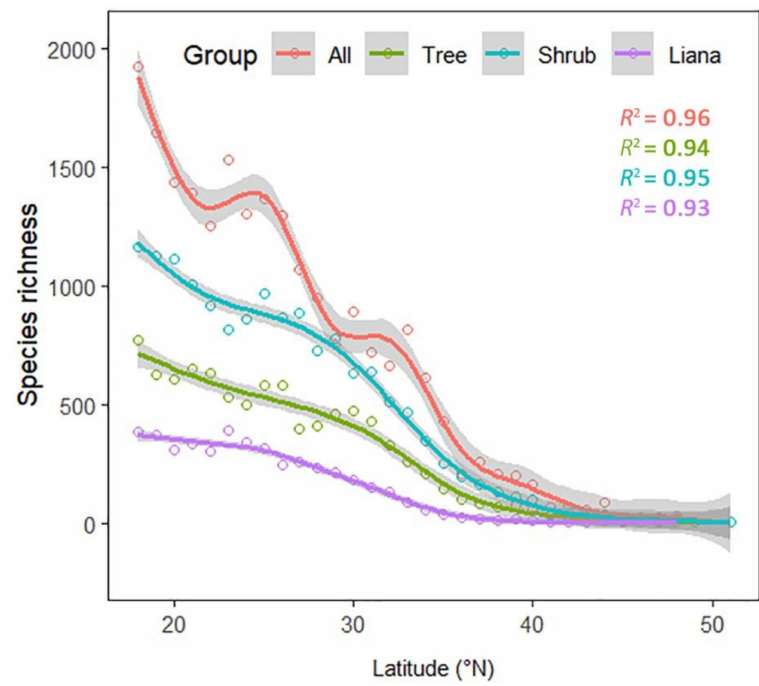
Figure 2. Species richness versus latitude for three growth forms of Chinese endemic woody seed plants. Lines and shades were fitted by parabolic regressions with 95% confidence intervals. All p -values <